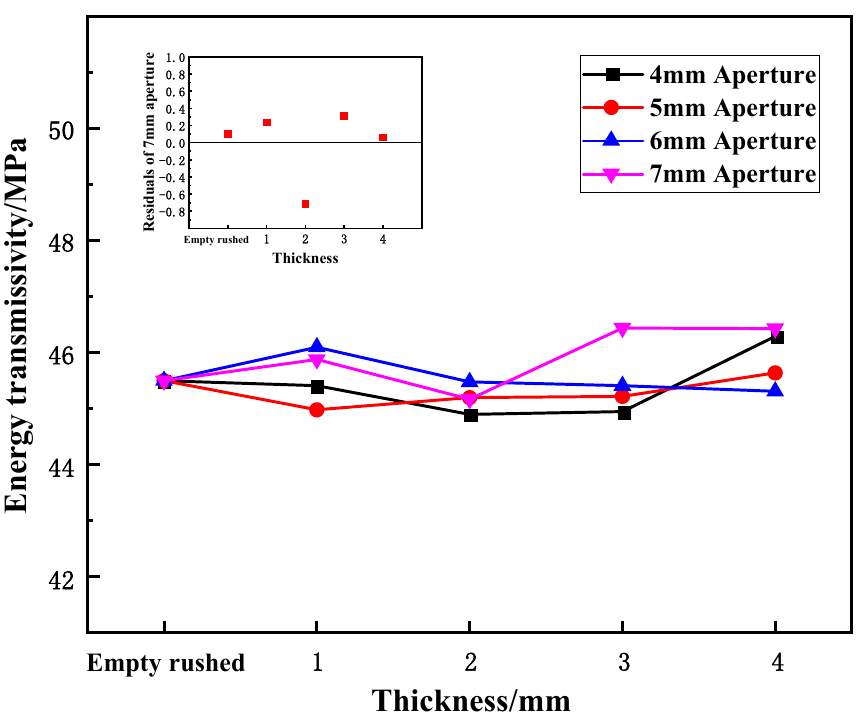
Figure 15. Variation trend of energy transmittance of wave-absorbing metal plate samples with thickness.